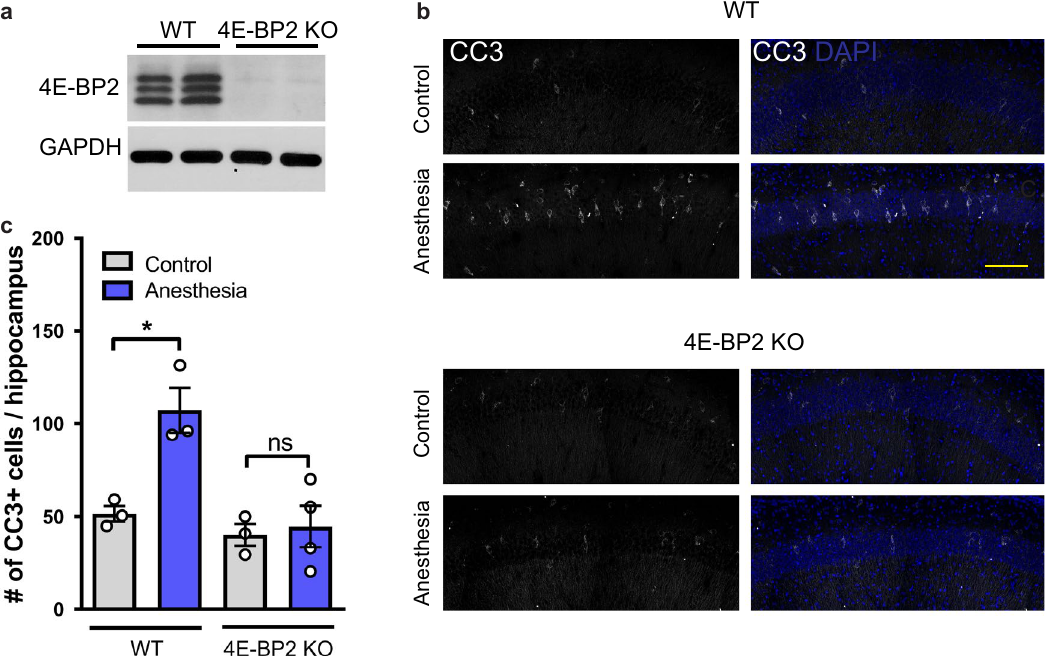
Figure 5. 4E-BP2 knockout juvenile mice do not show apoptosis induction following repeated general anesthesia. ( a ) Western blot analysis shows the lack of 4E-BP2 protein expression in the hippocampus of 4E-BP2 knockout (KO) mice. See Supplementary Fig. 1 for full-length blots. ( b ) Representative images showing immunostaining against CC3 (white) and DAPI (blue) in hippocampal sections from wild type (WT, left) and 4E-BP2 KO (right) control and repeated anesthesia-exposed mice (1.5% isoflurane, 2 h a day at postnatal days 15–17, fixed one hour after the last anesthesia session). ( c ) Quantification of CC3-positive cells. Repeated anesthesia induces apoptosis in juvenile wild type but not 4E-BP2 knockout mice ( F 3, 9 = 10.13; WT control (n = 3) versus WT anesthesia (n = 3), *p < 0.05; 4E-BP2 control (n = 3) versus 4E-BP2 anesthesia (n = 4), ns (not significant), p > 0.05. Data points represent individual mice. Data are presented as mean ±